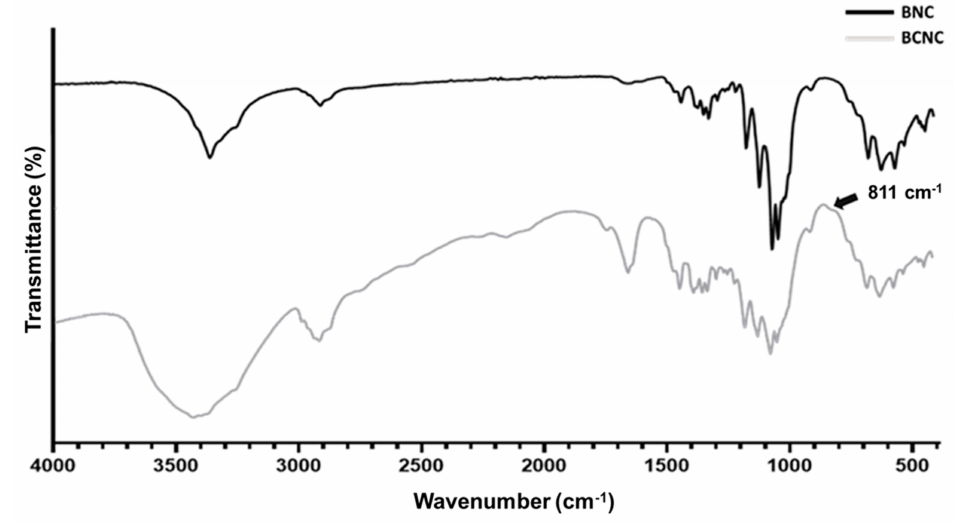
Figure 1. FTIR spectra of BNC and BCNC.